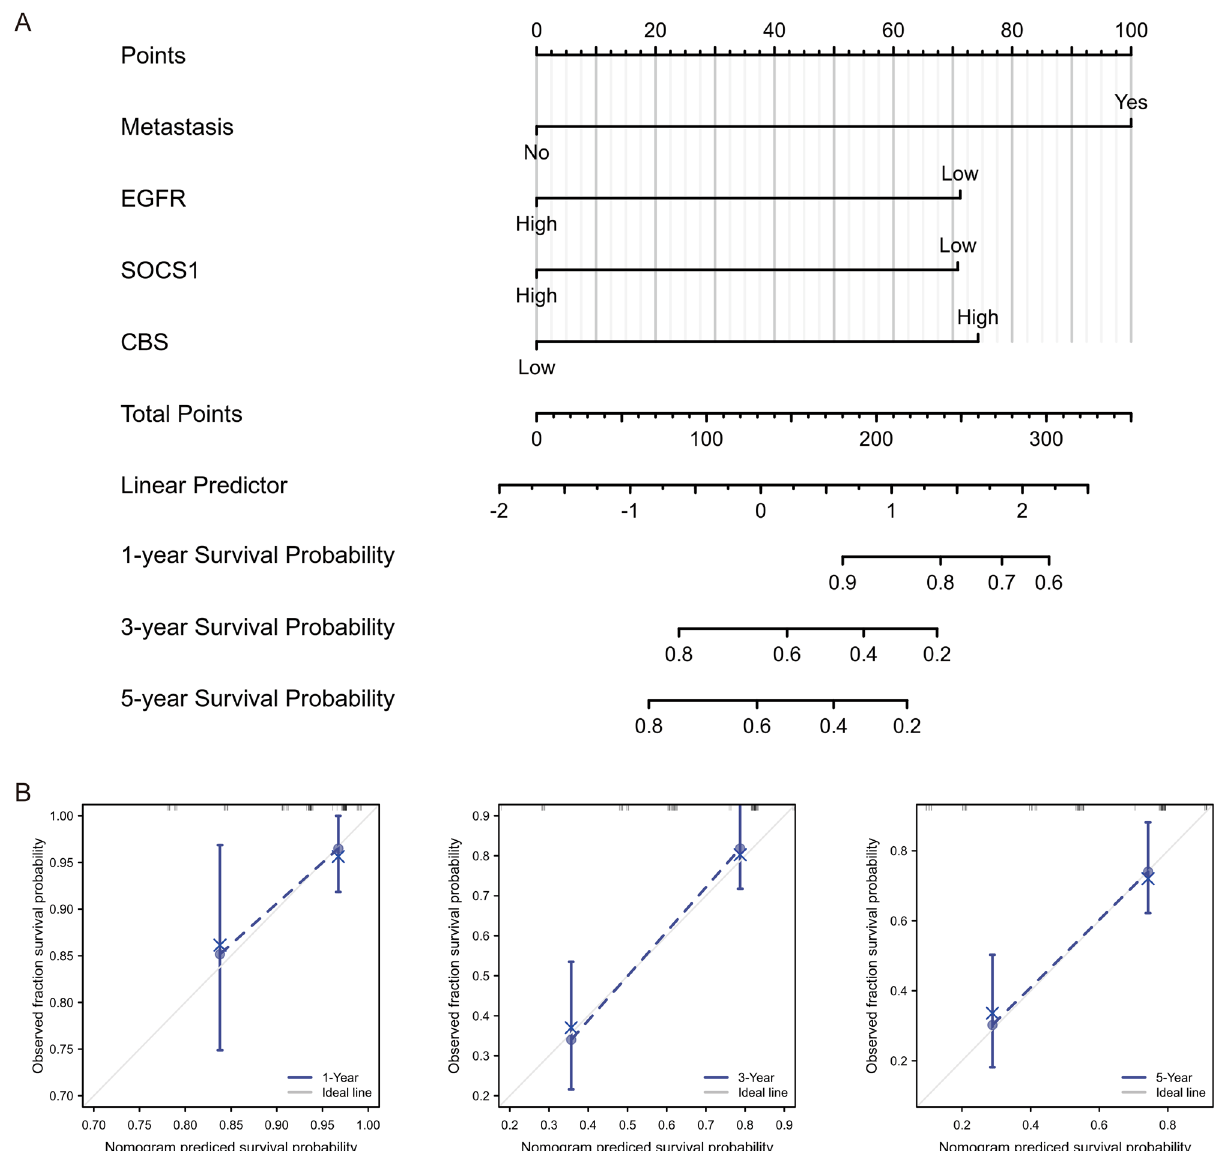
Figure 7. Visualization of the prognostic model for OS patients. ( A ) Construction of a nomogram to predict 1-, 3-, and 5-year survival probability. ( B ) Construction of 1-, 3-, and 5-year calibration curves to evaluate predictive efficacy of the